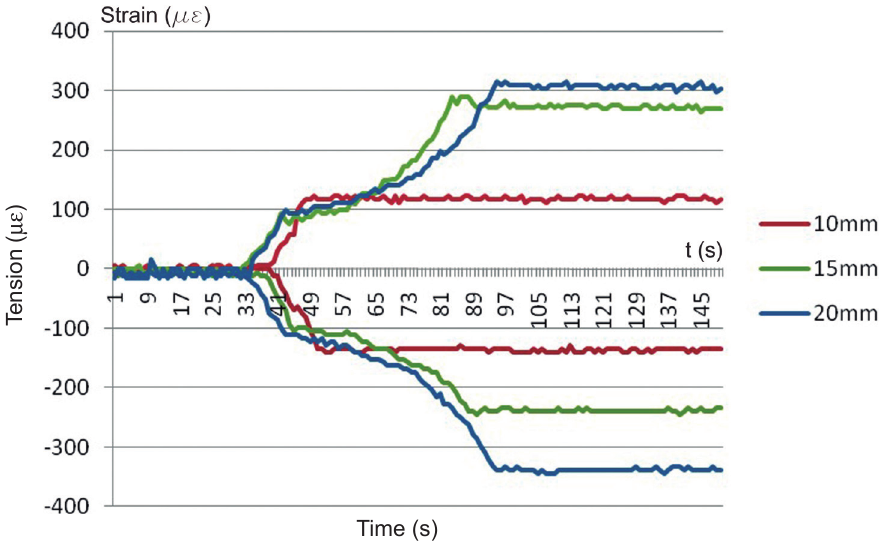
Figure 6- Measurements for tension (positive values) and compression (negative values) in different points of force application for Control group (C) –